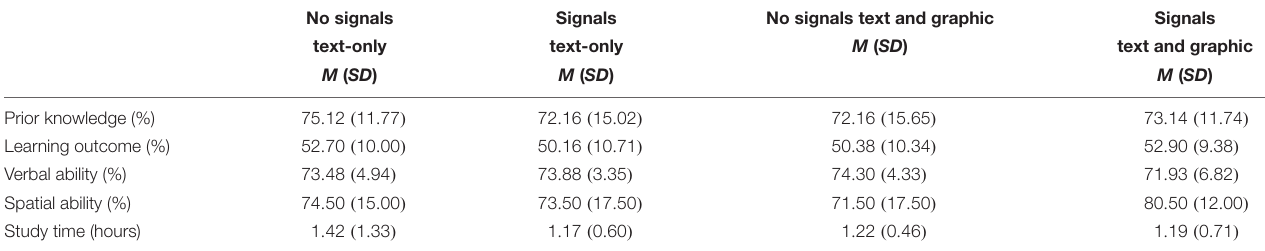
TABLE 2 | Means and standard deviations of the experimental conditions.